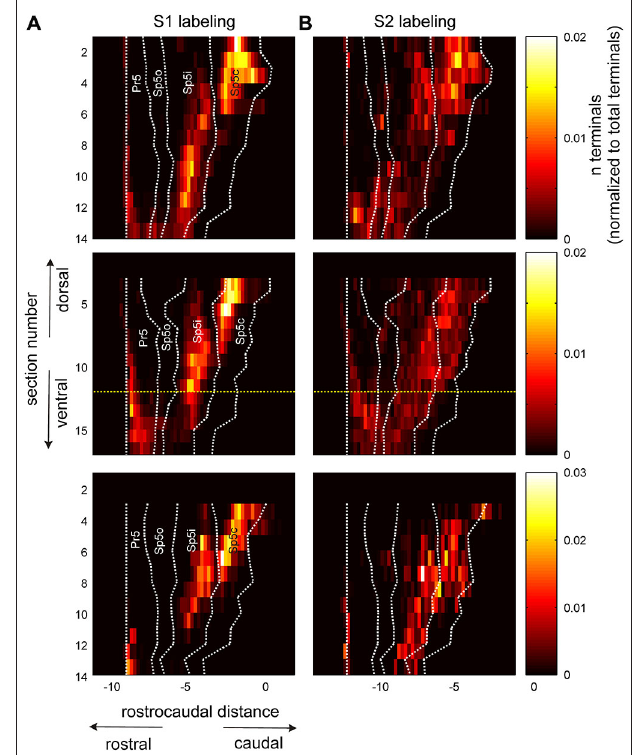
FIGURE 4 | Pattern of corticofugal terminal distribution across trigeminal sensory nuclei in both dorsoventral and rostro-caudal dimensions. (A) Terminal counts from an anterograde tracer injection into S1 cortex, normalized by total S1 terminal counts tallied across all horizontal sections through the brainstem. The different horizontal sections are arranged along the y axis with the dorsal most section located at the top. The rostral and caudal boundaries of the different trigeminal sensory nuclei have been overlaid on top using dotted white lines. All rostrocaudal measurements were normalized to the rostral boundary of the Pr5 nucleus for each section. Three animals are represented in the three rows. The yellow dotted lines in the second row denote the section shown in Figure 1D . (B) Identical plots for terminals labeled with an anterograde tracer injected into S2. All rostrocaudal distances are in